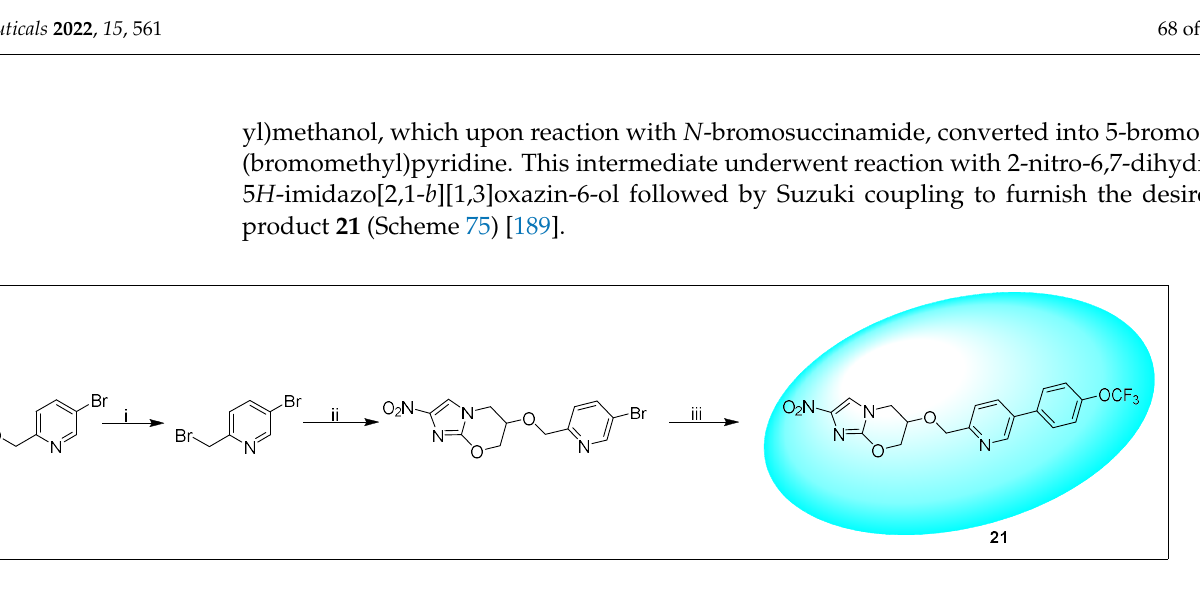
Figure 25. Activity profile of TBA-354 21